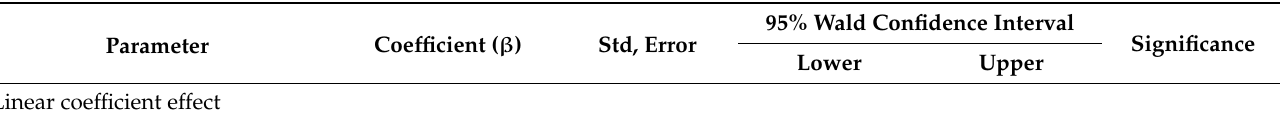
Table 8. The generalized linear model for the effects of L. mesenteroides, P. pentosaceus and E. gallinarum and their interaction on the total titratable acidity (TTA) of pearl millet